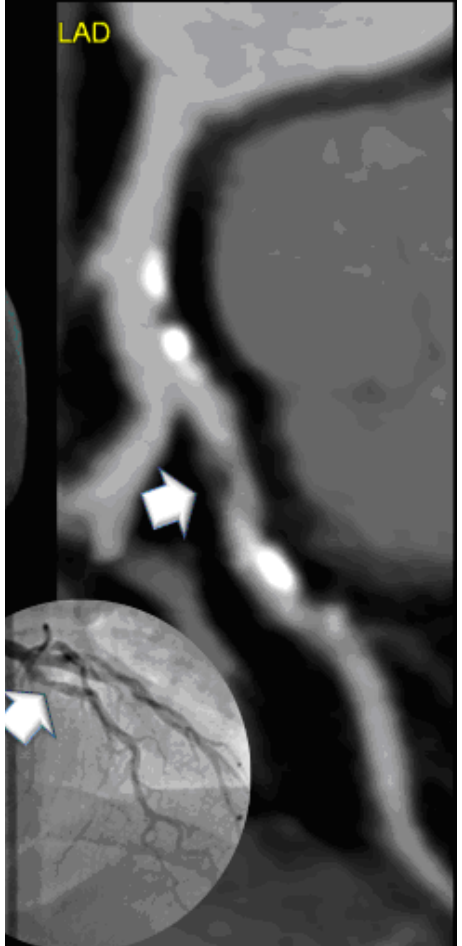
Figure 3. A 49 year-old-male with high grade mid LAD stenosis (> 70%), a dense mixed fibrous plaque of 135 HU and more calcifications (white spots). Three cardiovascular risk factors (arterial hypertension, dyslipidemia (total cholesterol 300 mg/dl, high c-LDL of 236 mg/dl), and positive family history) with walking through angina. Vitamin D supplementation for 6 months. Coronary artery calcium score was moderate with 134.2AU. Invasive coronary angiography confirmed stenosis of 80% (inlay bottom left).